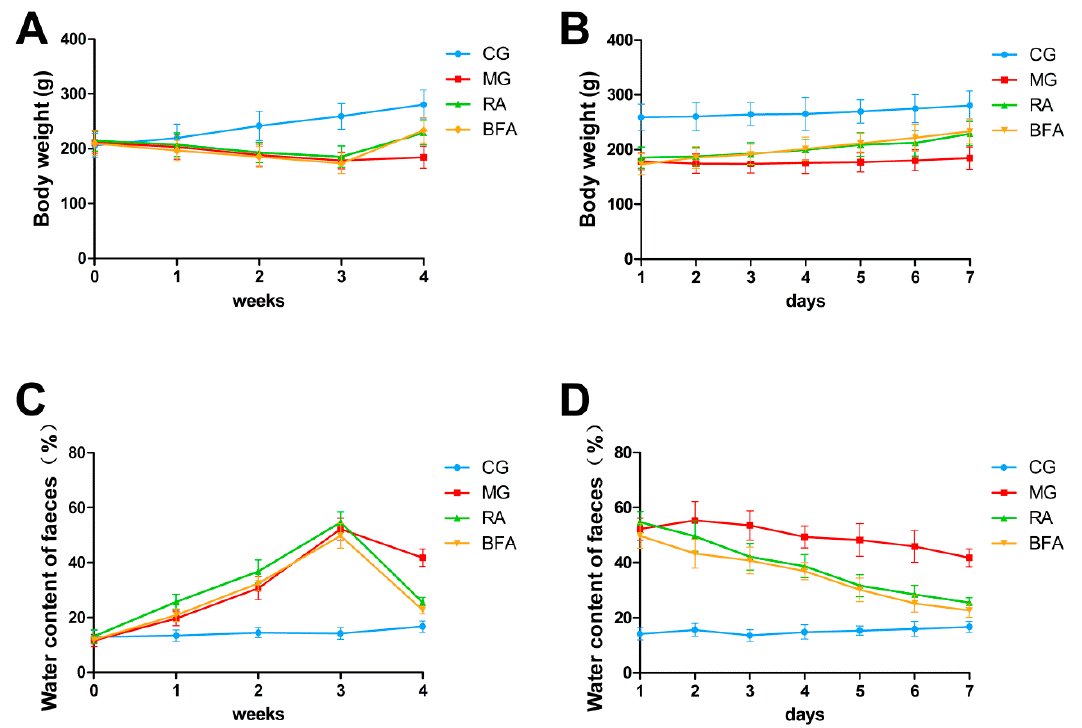
Figure 1. Comparison of body weight and fecal moisture percentage among diverse groups: ( A ) The curves of growth are based on the average body weight for each of the four groups during the whole experiment; ( B ) the curves show the changes of body weight for the four groups during treatment; ( C ) the curves of fecal moisture percentage are based on average values for the four groups during the whole experiment; and ( D ) the curves show the changes of fecal moisture percentage for the four groups during treatment. ( n = 10 rats in each group).